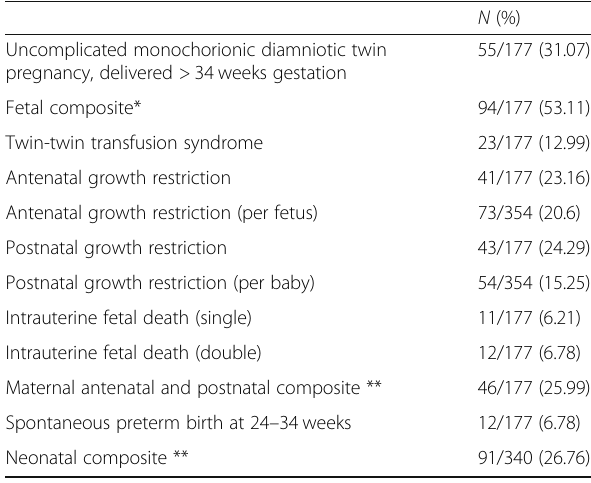
Table 2 Number of events (per pregnancy ( n = 177)